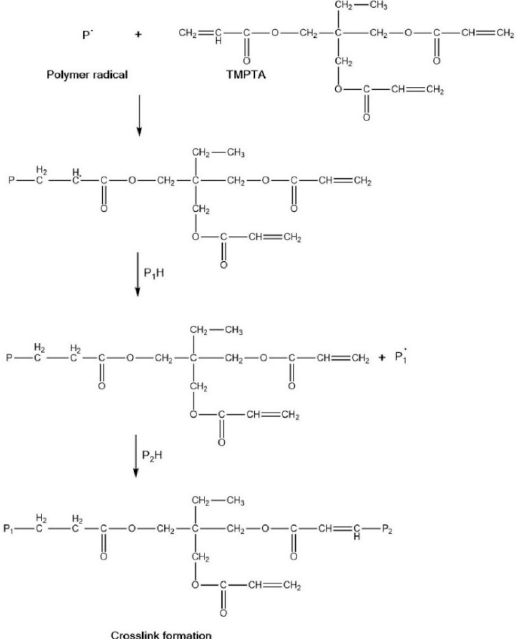
Figure 1. Trimethylol propane triacrylate (TMPTA) coagent reacts with polymer radicals [36,37] .